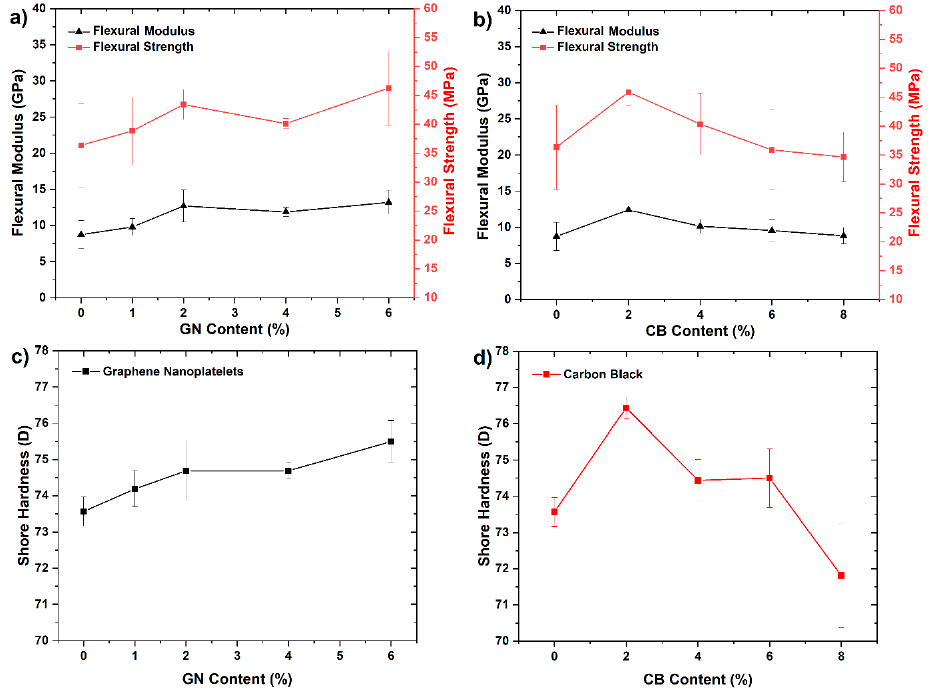
Figure 6. Flexural strength and modulus of EP/SG composites depending on the content of sec- ondary nanofillers. ( a ) Graphene nanoplatelets; ( b ) carbon black; Shore hardness versus GN ( c ) and CB ( d ) percentage.